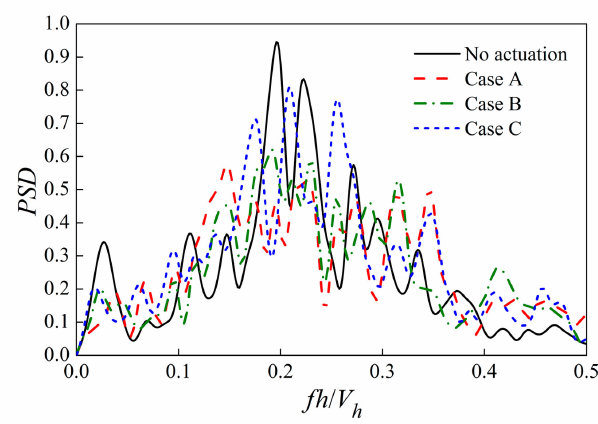
Figure 11. Power spectral density of RMS drag coe ffi